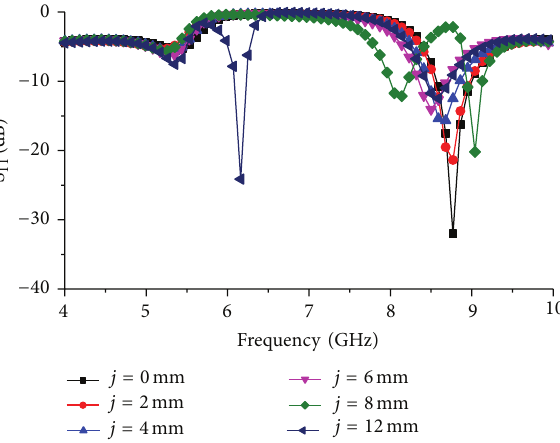
Figure 9: Resonator resonance response for change in width “ 𝑘 .”